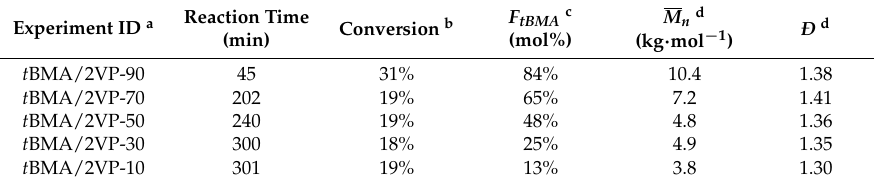
Table 2. Molecular weight and composition characterization of tert-butyl